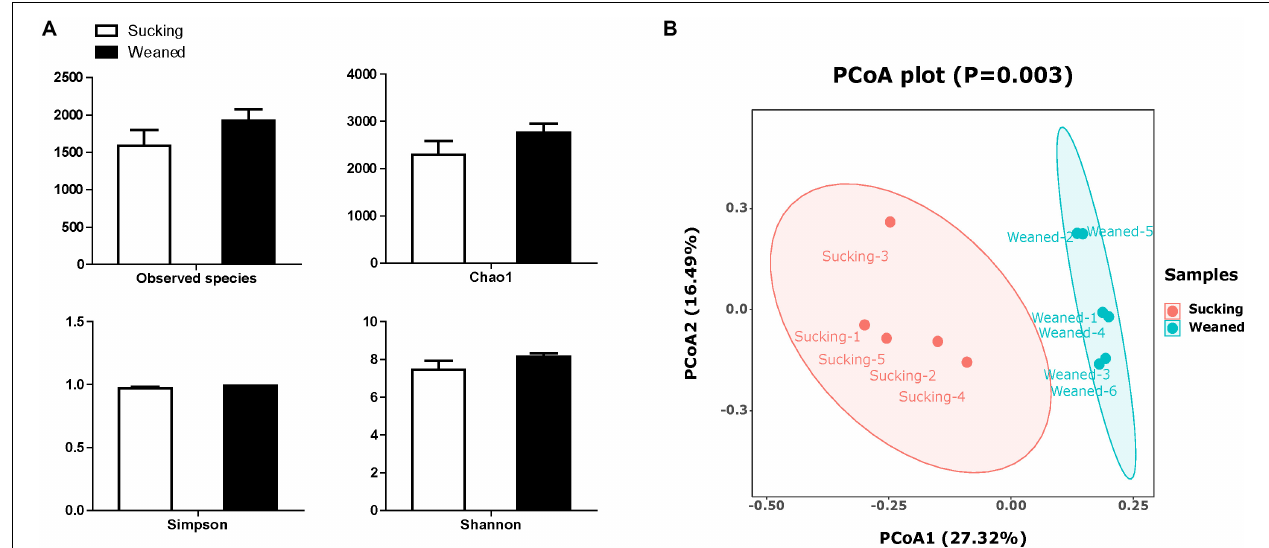
FIGURE 7 | Alpha diversity and beta diversity of the gut microbiota of sucking piglets and weaned piglets. (A) The number of observed species and Shannon, Simpson and Chao1 indices of the gut microbiota. All values are expressed as the means ± SEMs ( n = 5–6). (B) Principal coordinates analysis (PCoA, Bray–Curtis distance) plot of the gut microbiota.